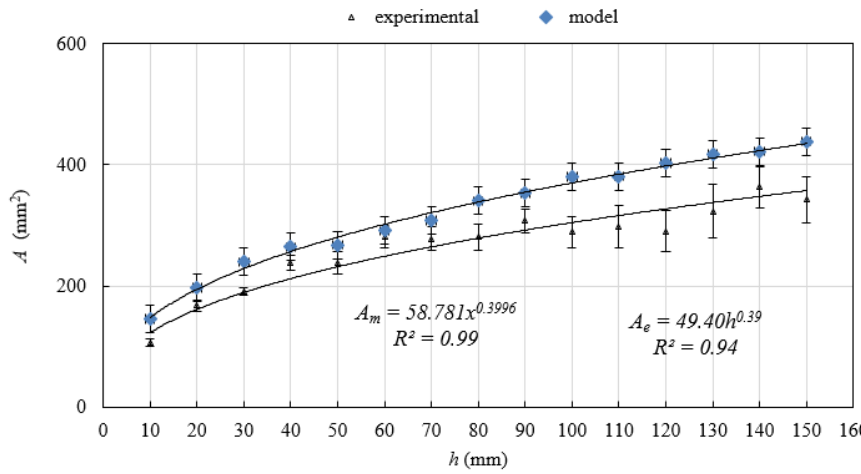
Figure 10. Influence of the drop height on the experimental and model contact surface, for concrete type substrates. Am — means model contact surface, Ac — means experimental contact surface. Error bars represent mean ± SD (standard deviation). bars represent mean ± SD (standard deviation).